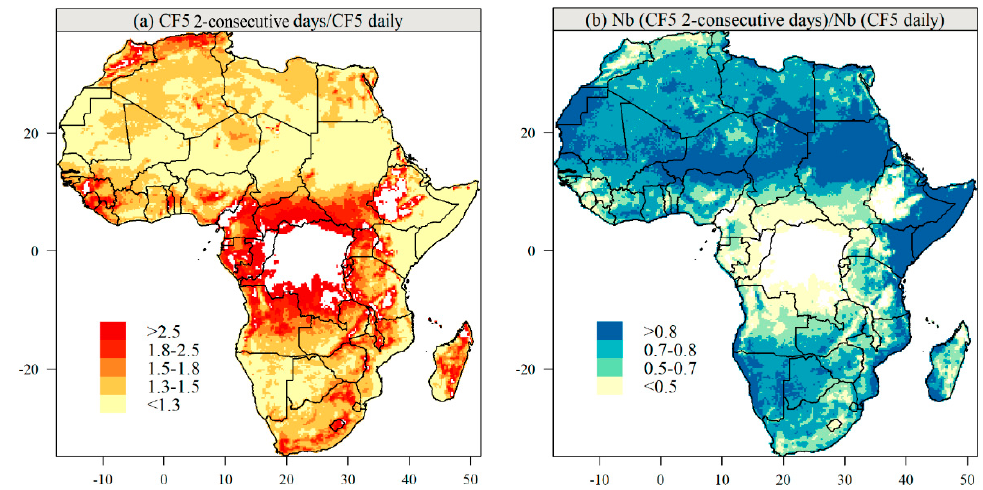
Figure 7. Low-wind days: ( a ) the ratio of the fifth percentile of capacity factor over two consecutive days to fifth percentile of daily capacity factor (CF5) for the 2000–2017 period; ( b ) the proportion of the number of wind turbines required to meet demand in at least 95% of days of the year when two-consecutive-day mean CF is used to the case where daily CF5 values are used. The areas for which the fifth percentile of the capacity factor is zero are masked (white color).